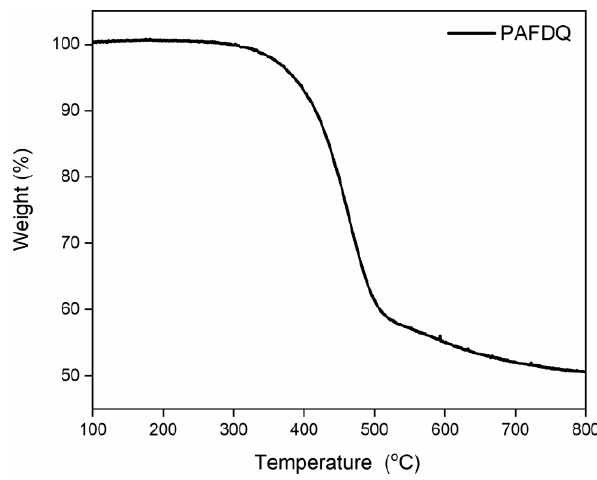
Figure A1. TGA data of PAFDQ.